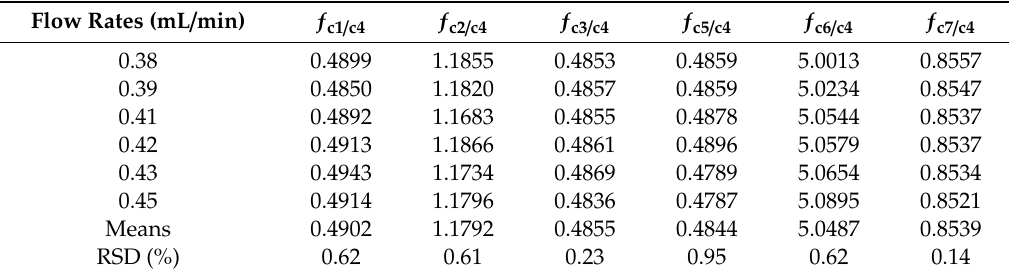
Table 6. RCFs in di ff erence flow